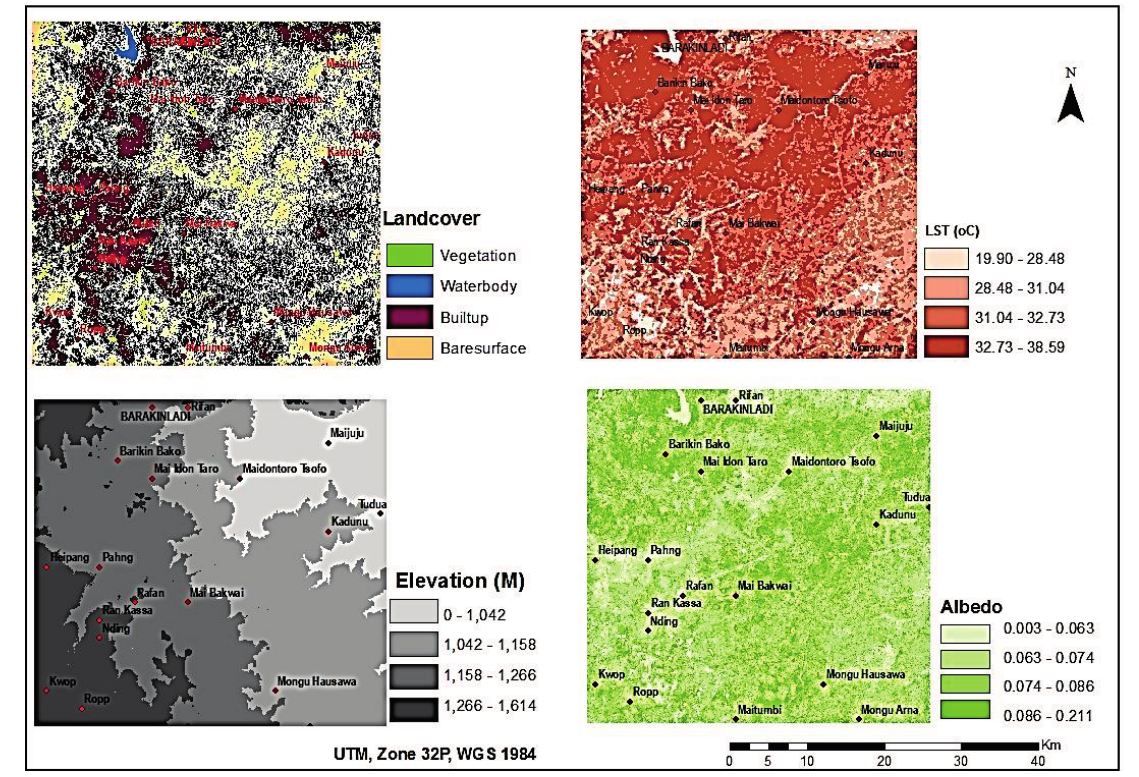
Figure 9. Landcover, LST, topography and albedo in Barakinladi in